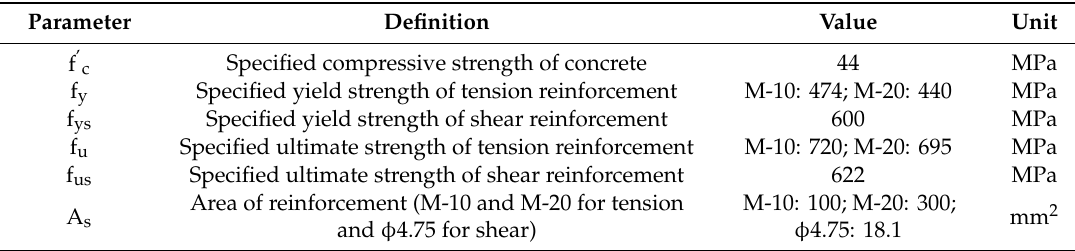
Table 2. Sprayed glass fiber-reinforced polymer (GFRP)